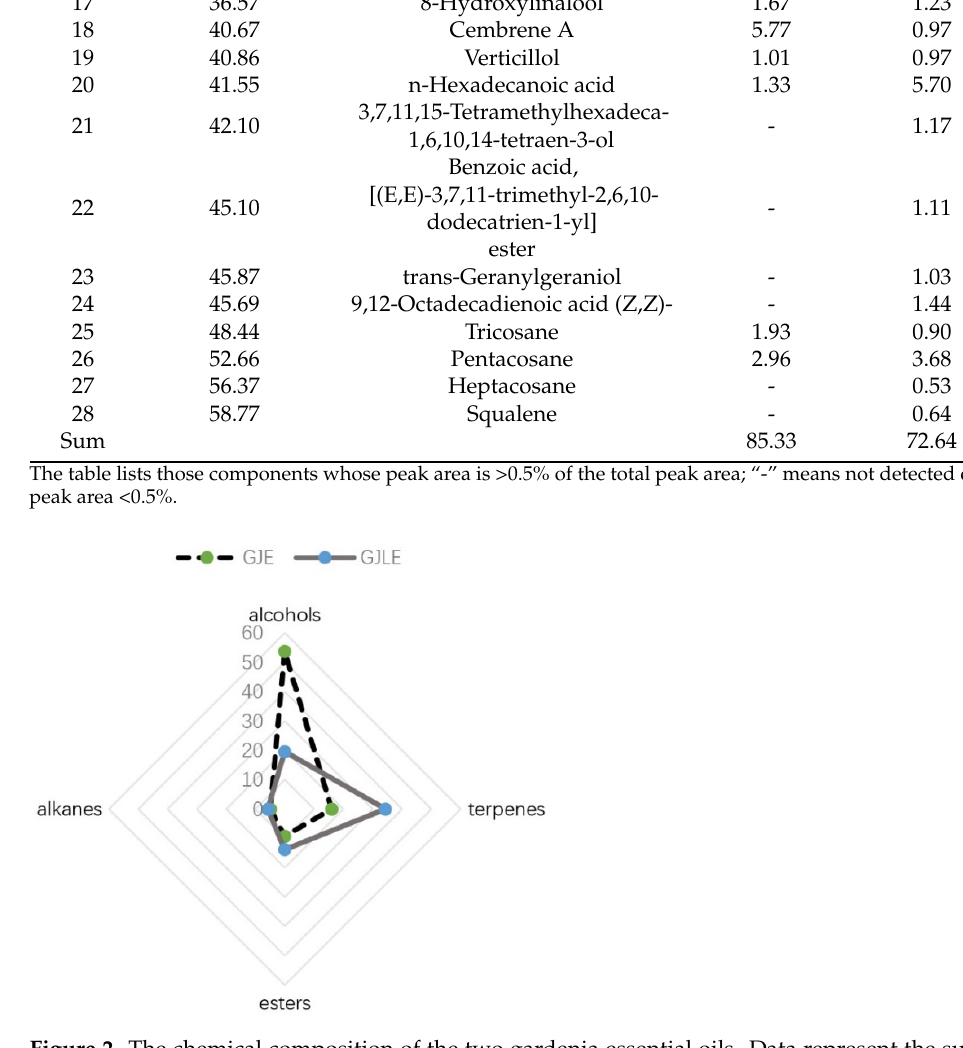
Figure 2. The chemical composition of the two gardenia essential oils. Data represent the sum of compounds with a relative content higher than 0.5% in the oils with the same chemical type.